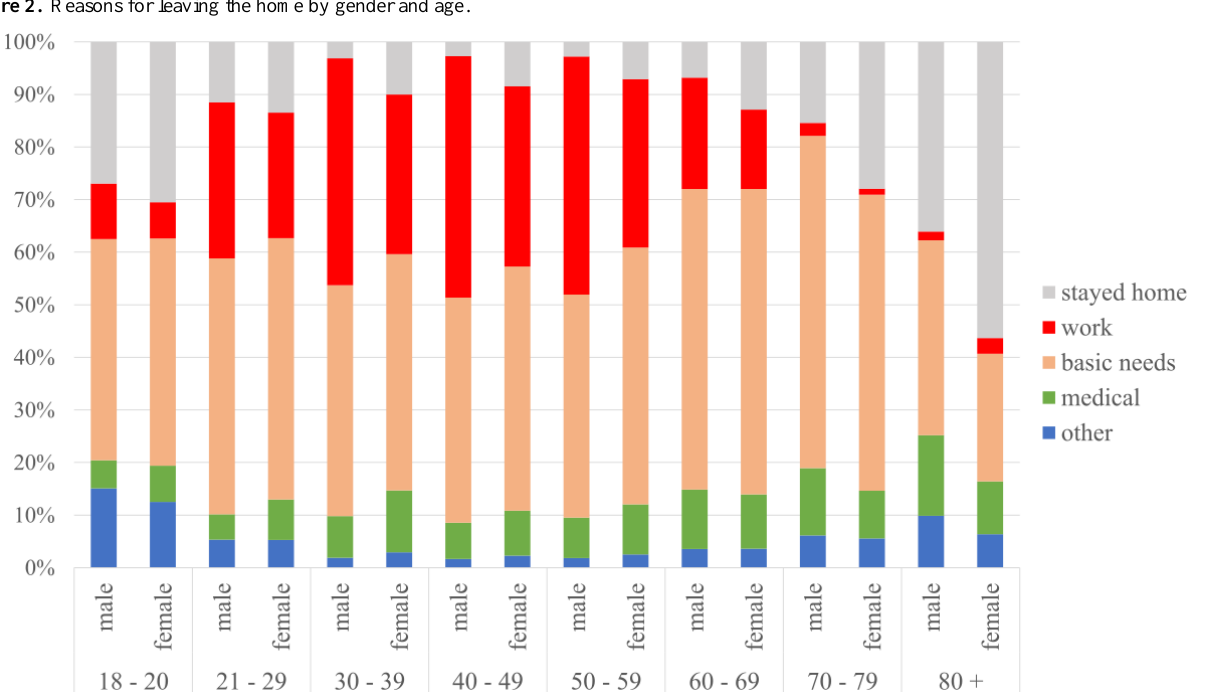
Figure 2: covering basic needs (supermarkets, bakery, and